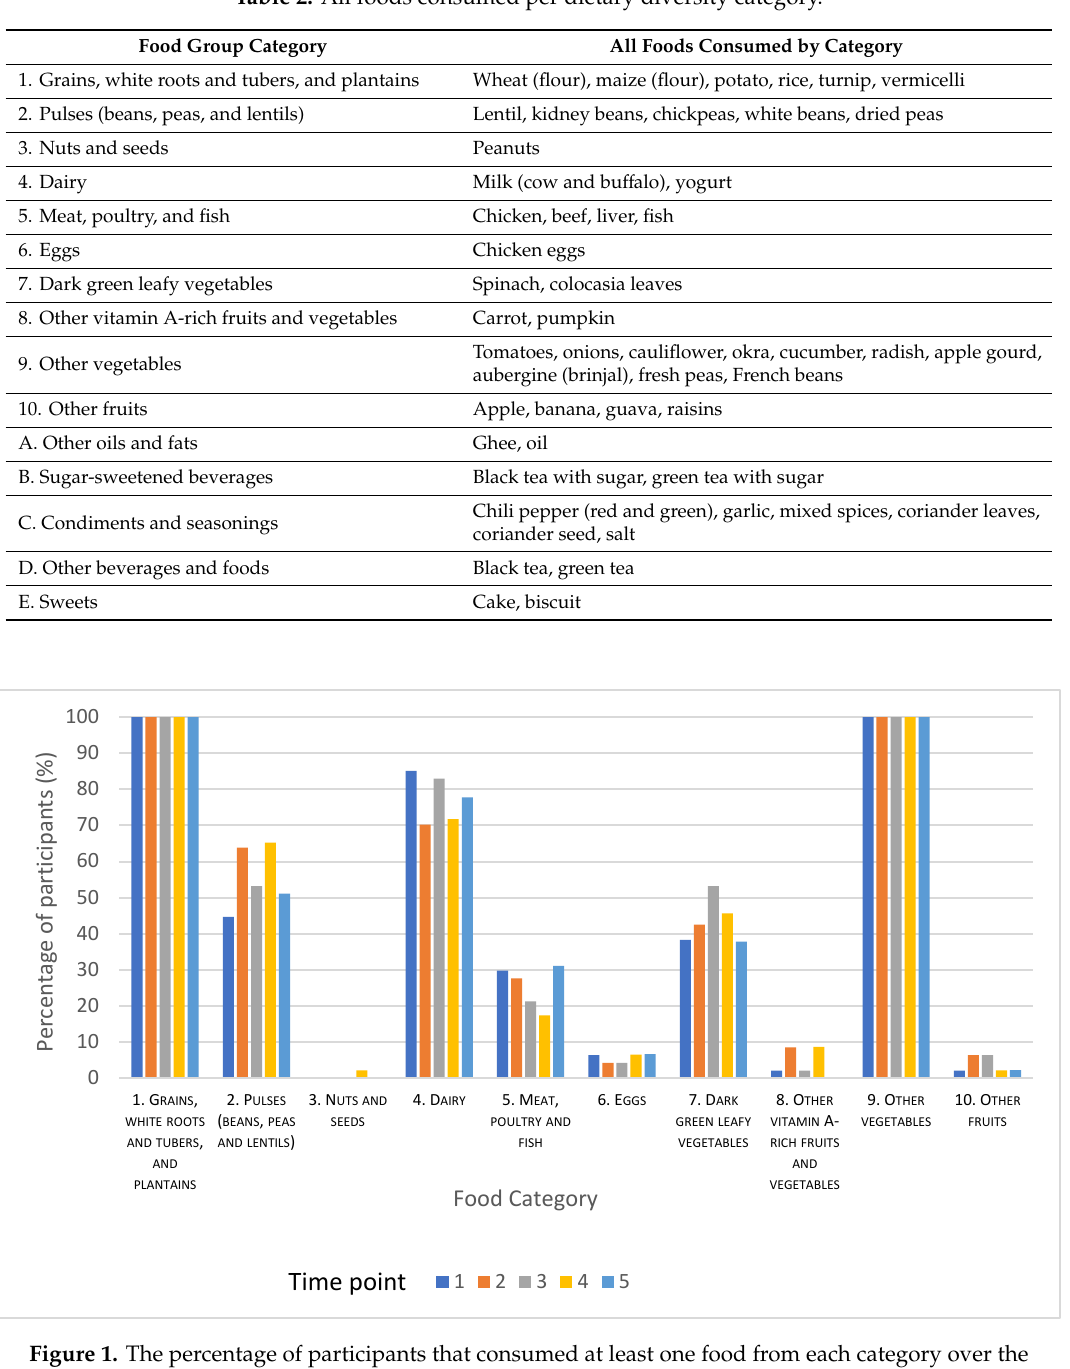
Table 3. The frequency (%) distribution of the food group diversity score at each time point. Food Group Score